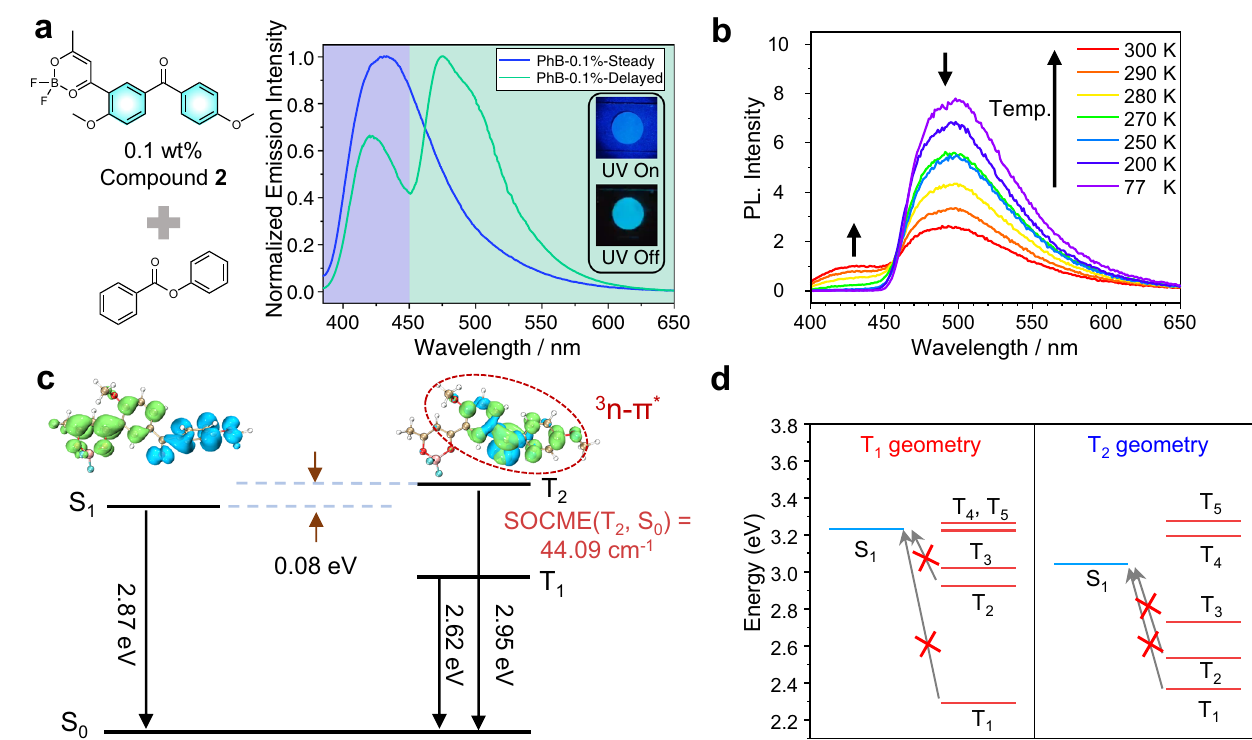
Fig. 2 | Photophysical properties of compound 2 system. a Molecular structure of compound 2 , steady-state and delayed emission spectra (1ms delay) of 2 -PhB- 0.1%powderatroomtemperature,and fl uorescenceandafterglowphotographsof 2 -PhB-0.1% powder; b Temperature-dependent delayed emission spectra (1ms delay) of 2 -PhB-0.1% powder from 77K to 300K; c Experimental and TD-DFT cal- culation results of S 1 , T 1 , T 2 statesof compound 2 : the isosurface maps ofelectron-